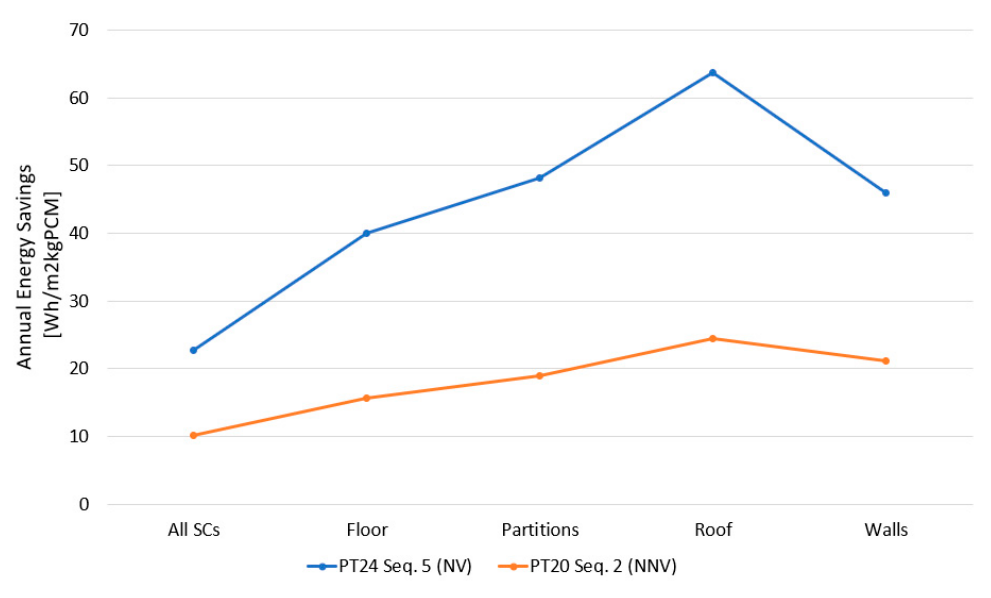
Figure 14. Electricity saving potential per kg PCM for different equipped surfaces of building A. Energies 2020 , 13 , x FOR PEER REVIEW